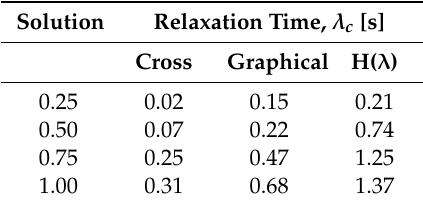
Table 4. Critical relaxation times obtained graphically, with the Cross model, and with the relaxation spectra. Solution